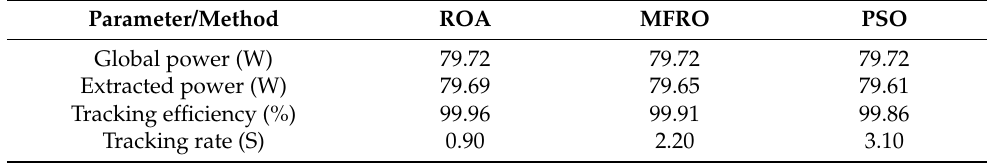
Table 6. Numerical results of the ROA, MRFO, and PSO methods in pattern